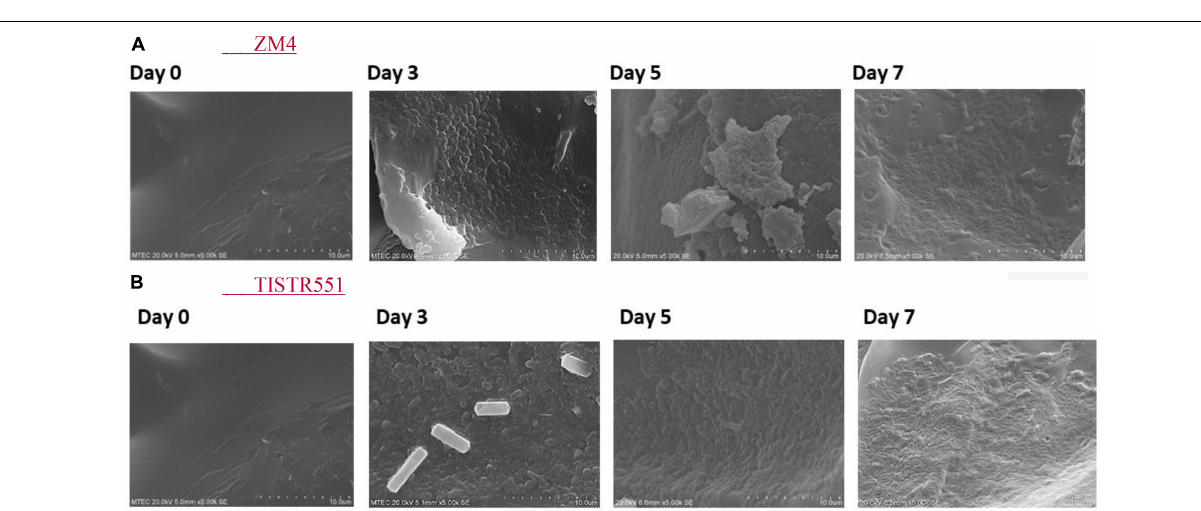
FIGURE 3 | Zymomonas mobilis ZM4 (A) and TISTR551 (B) attachments on GP110 plastic composited corn silk on days 0, 3, 5, and 7 monitored by SEM with 5000 ×